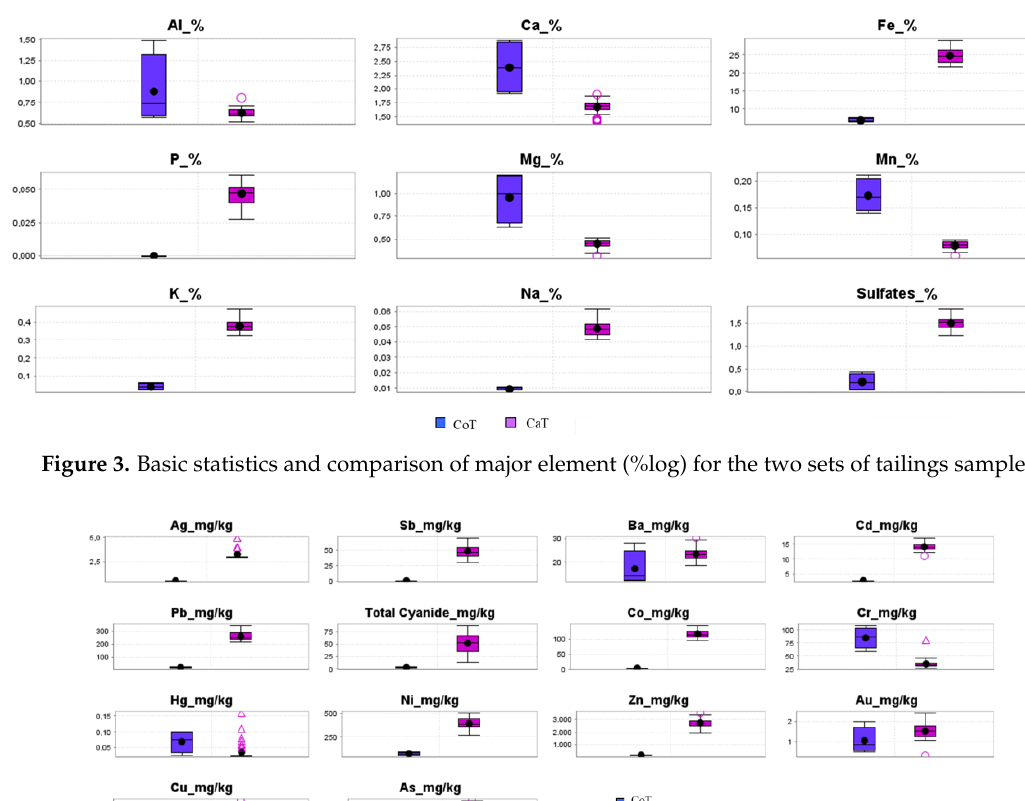
Figure 3. Basic statistics and comparison of major element (%log) for the two sets of tailings samples.